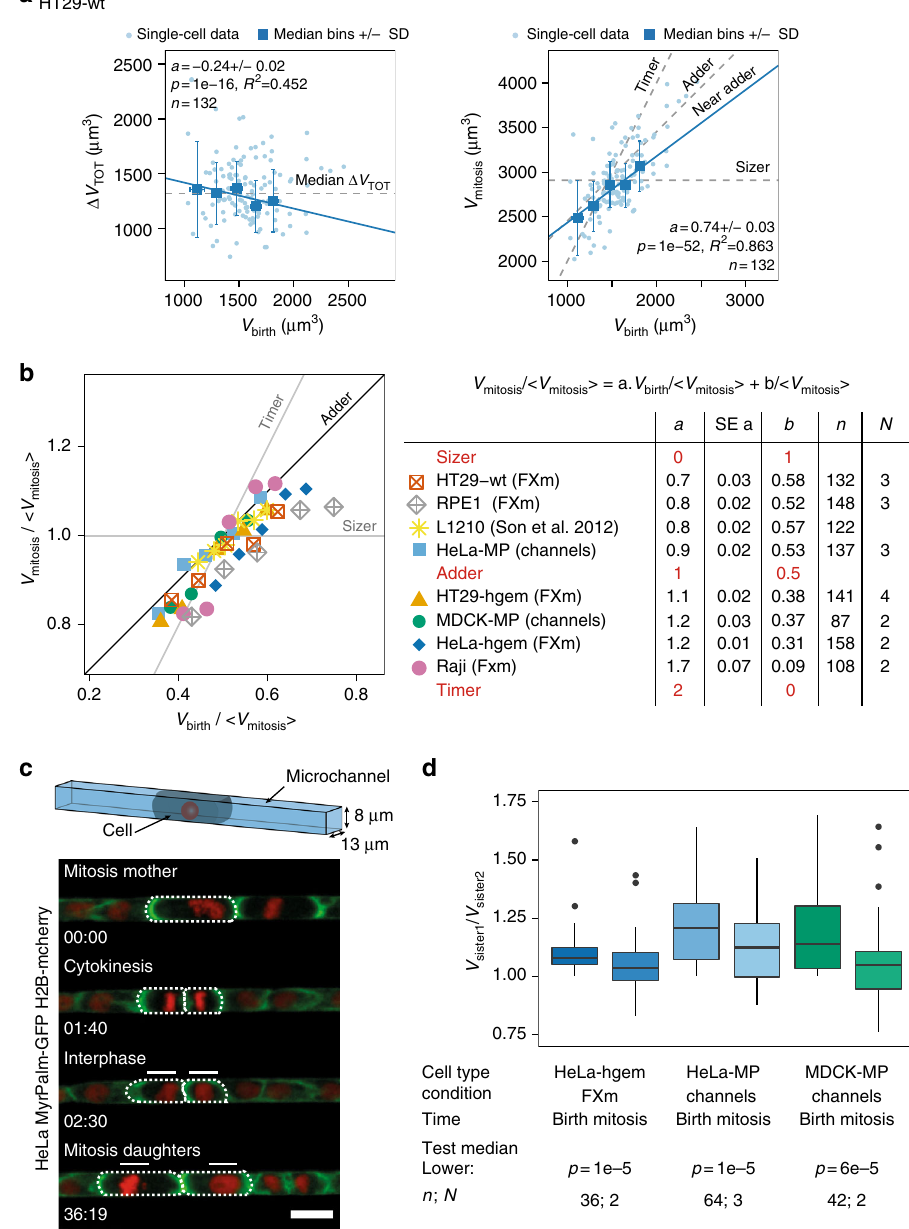
Fig. 2 Adder or near-adder behavior in cultured mammalian cells. a Left: total volume gained during one cell division cycle Δ t TOT vs. volume at birth V birth for wild-type HT29 cells ( N = 3). Right: volume at mitosis V mitosis vs. V birth . Dashed gray lines show the expected trends in case of a sizer, an adder, and a timer. Blue lines: linear fi t on the binned data weighted by the number of observations in each bin. b Left graph: plot of volume at mitosis vs. volume at birth rescaled by the mean volume at mitosis for various cultured mammalian cell lines. Ideal slopes for stereotypical homeostatic behaviors are shown as black and gray lines. The points are median bins (see Supplementary Fig. 2b for equivalent graphs with single points). For each cell type, a linear fi t V = aV + b is made on the bins weighted by the number of observation in each bin. Right table: estimates from the linear regression for each cell mitosis birth type: a (slope coef fi cient), s.e. a (standard error for a ), b (slope intercept). The theoretical slope coef fi cients and intercepts expected in case of sizer, adder, or timer are also indicated. L1210 are mouse lymphoblastoid cells from ref. 33 . Apart from the L1210 cells buoyant mass, data are volumes acquired with either the FXm or the microchannel methods). c Top: scheme of a cell con fi ned in a microchannel (nucleus in red). Bottom: sequential images of an asymmetrically dividing HeLa cells expressing MyrPalm-GFP (plasma membrane, green) and Histon2B-mcherry (nucleus, red) growing inside a microchannel. The outlines of the cell of interest and its daughters are shown with white dotted lines. Daughter cells are indicated with solid white bars. Scale bar is 20 µ m. Time is hours:minutes. d Ratio of volume in pairs of sister cells at birth and mitosis for MDCK-MP and HeLa-MP cells growing inside microchannels. Control, in non-con fi ned condition, corresponds to HeLa-hgem cells measured with FXm. A Wilcoxon signed rank test was performed to test that the median ratio was lower from birth to mitosis in each condition. See also Supplementary Figure 2 and Supplementary Movie